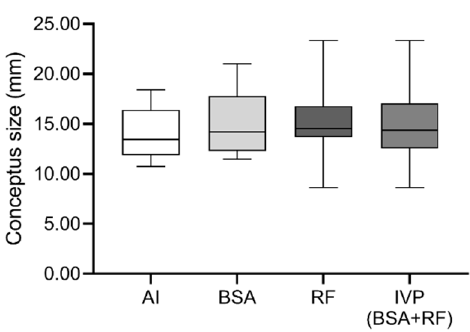
Figure 1. Distribution of conceptus size at day 30 of gestation of embryos produced by artificial insemination (AI), bovine serum albumin (BSA), reproductive fluids (RF), or in vitro-produced (IVP, corresponding of BSA + RF). The boxplot is represented by the first quartile, the median and the third quartile, with minimum and maximum as whiskers.